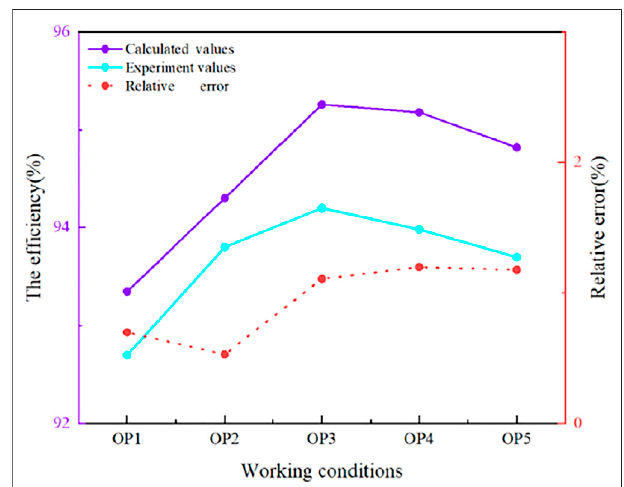
FIGURE 6 | Comparison of the calculated output and actual machine output under fi ve coassociated working conditions.